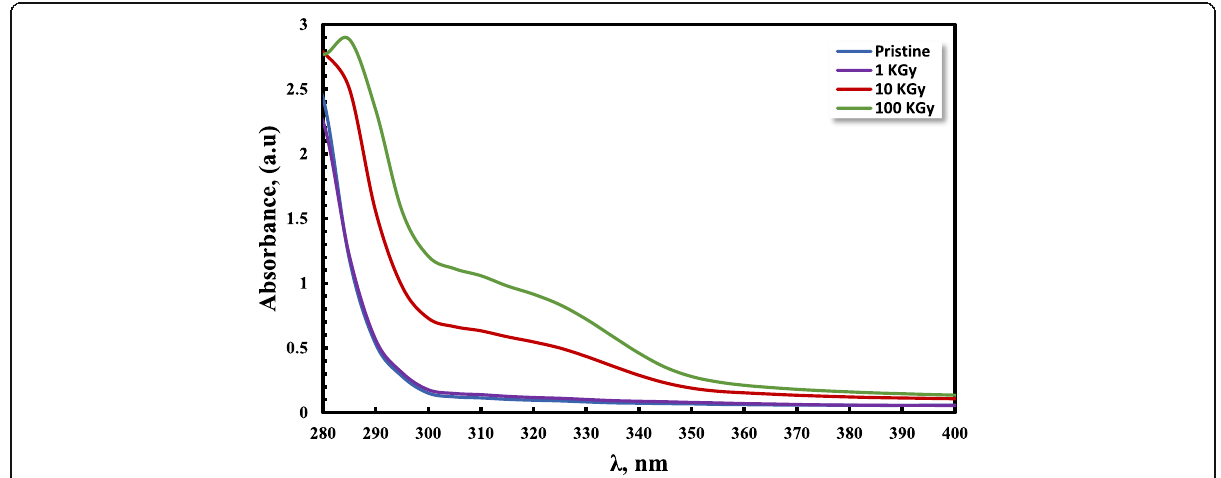
Fig. 7 UV – visible spectra of the pristine and gamma-irradiated Makrofol DE 1-1 at different doses